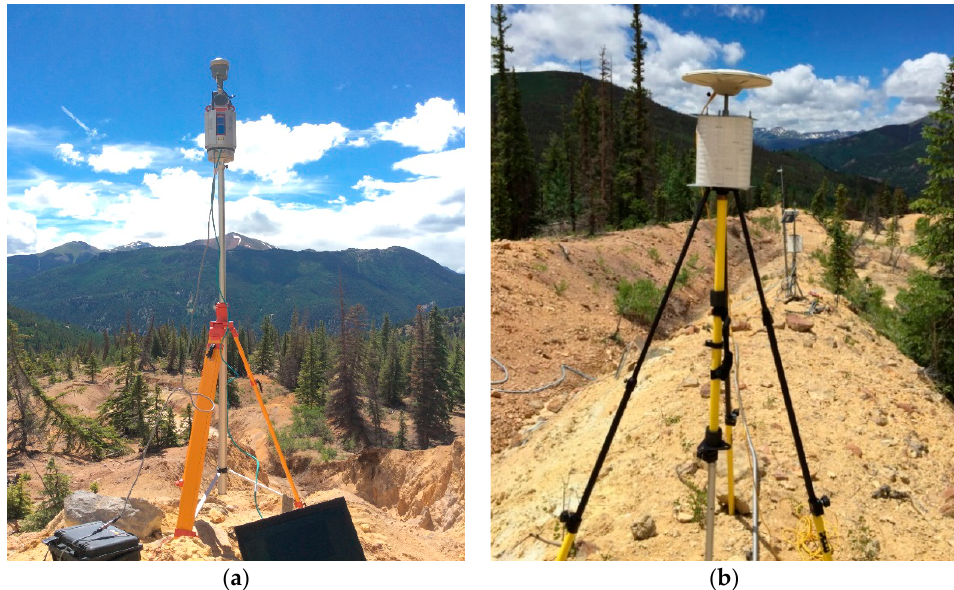
Figure 4. Photos showing GNSS and TLS equipment used for the TLS survey. ( a ) A Trimble R10 GNSS unit and a RIEGL VZ-2000 laser scanner that were mounted on a 4-m-high elevating tripod; ( b ) A cylinder laser reflector (20-cm in diameter, 25-cm in height) and a Trimble Zephyr 2 Geodetic GNSS antenna (paired with a Trimble NetR9 receiver).